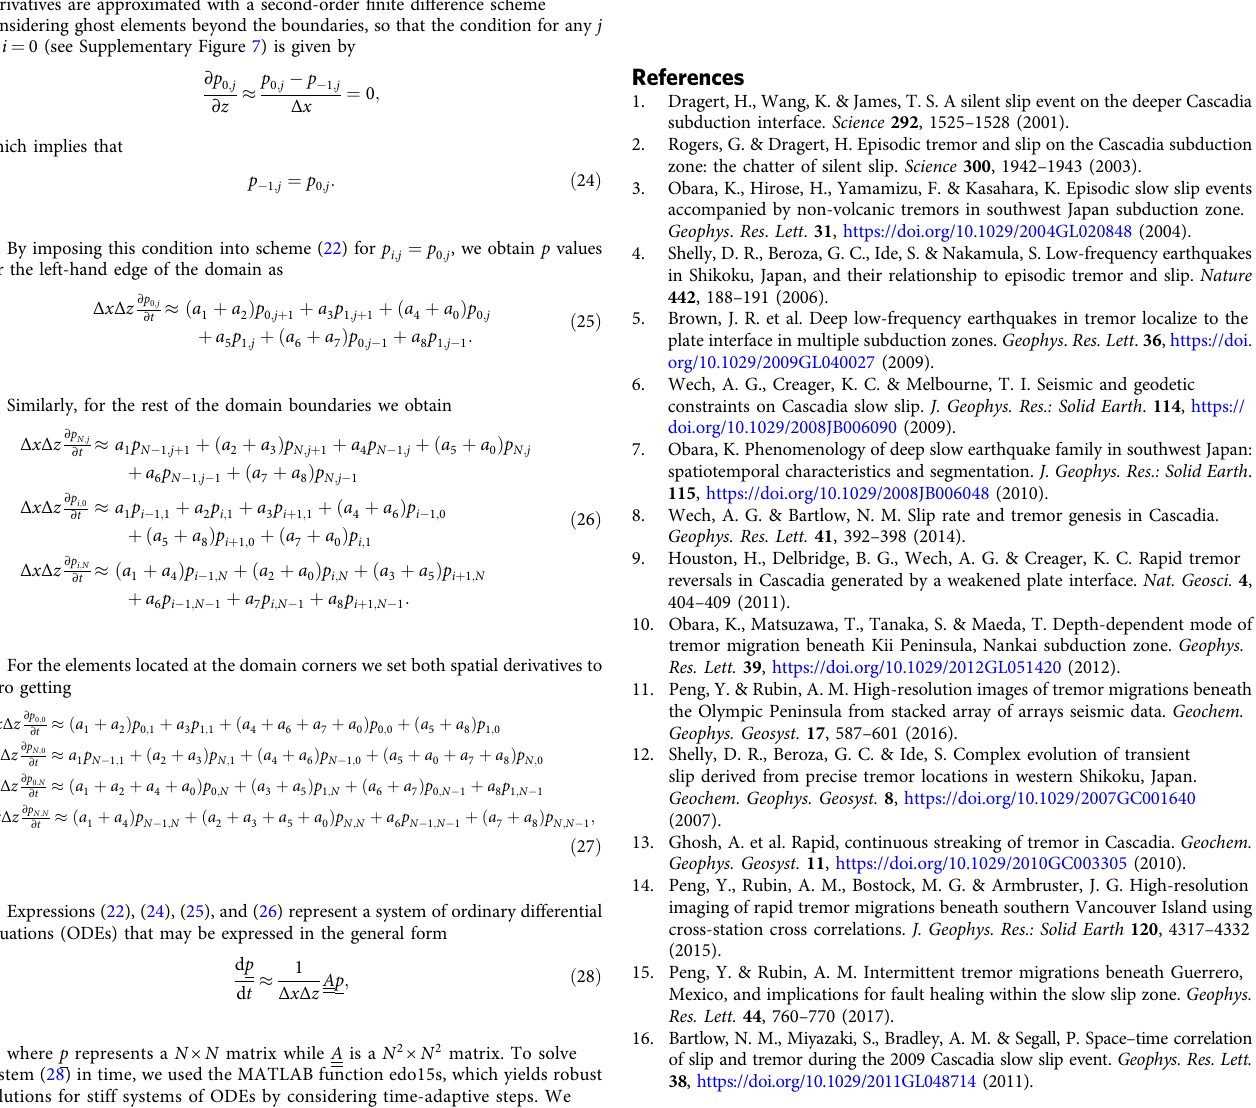
Figure 8. Parametric analysis of the non-linear poroelastic equation . We performed a parametric analysis of Eq. (2) to identify the physical conditions leading to pore- pressure waves traveling with the observed RTM speeds. We considered values of 10 (cid:2) 10 <k 0 < 10 (cid:2) 16 m 2 and pore pressure gradients ( ∇ p 0 ) ranging between 10 − 1 and 10 1 MPa km − 1 . For γ parameter, we explored values around those derived from experimental tests, between 10 − 8 and 10 − 5 [Pa − 1 ] 40 , and estimated porosities ( ϕ ) for the Cascadia subducted slab, between 1 and 2% 28 . For each combination of the parameters, we solved Eq. (2) assuming values for the remaining constants shown in Table 1 and track the pressure-wave front along 15km for threshold values of p ranging between 1 and 10kPa. Results obtained in the parametric analysis are summarized in Fig. 1c and Supplementary Figures 3 and 4, from which we determined the ranges of the model parameters (Table 2) producing pressure waves in the plate interface with speeds between 1 and 200